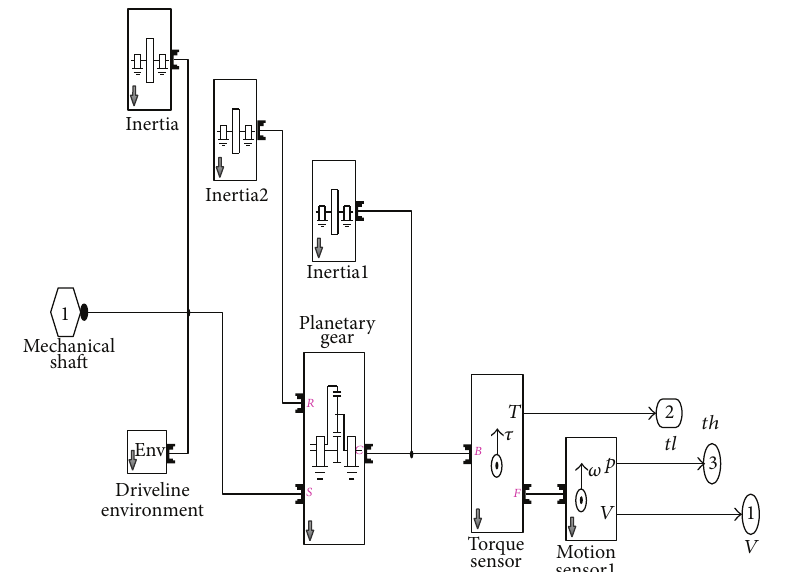
Figure 8: Gearhead modeling for control actuation system.